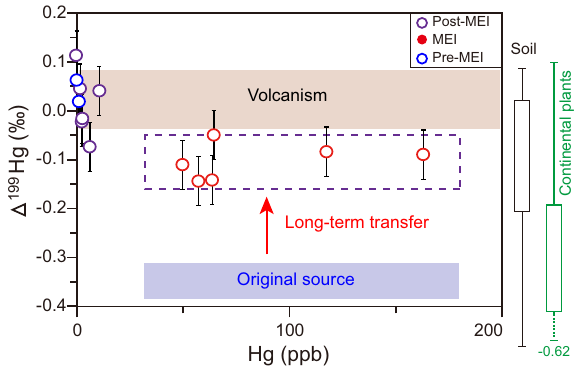
Fig. 3 Crossplot of Δ 199 Hg versus Hg for Katsuyama. The light blue rectangle represents the composition of the original source because Δ 199 Hg values become more positive at remote sites (purple dashed rectangle) due to atmospheric reactions 39 . Vertical bars for Δ 199 Hg represent standard deviation (2 σ ) values. The range of Δ 199 Hg values for volcanism, soil, and continental plants and sediments are from Yin et al. 71 . MEI = mercury-enriched interval. Source data are provided in the Supplementary data fi le.